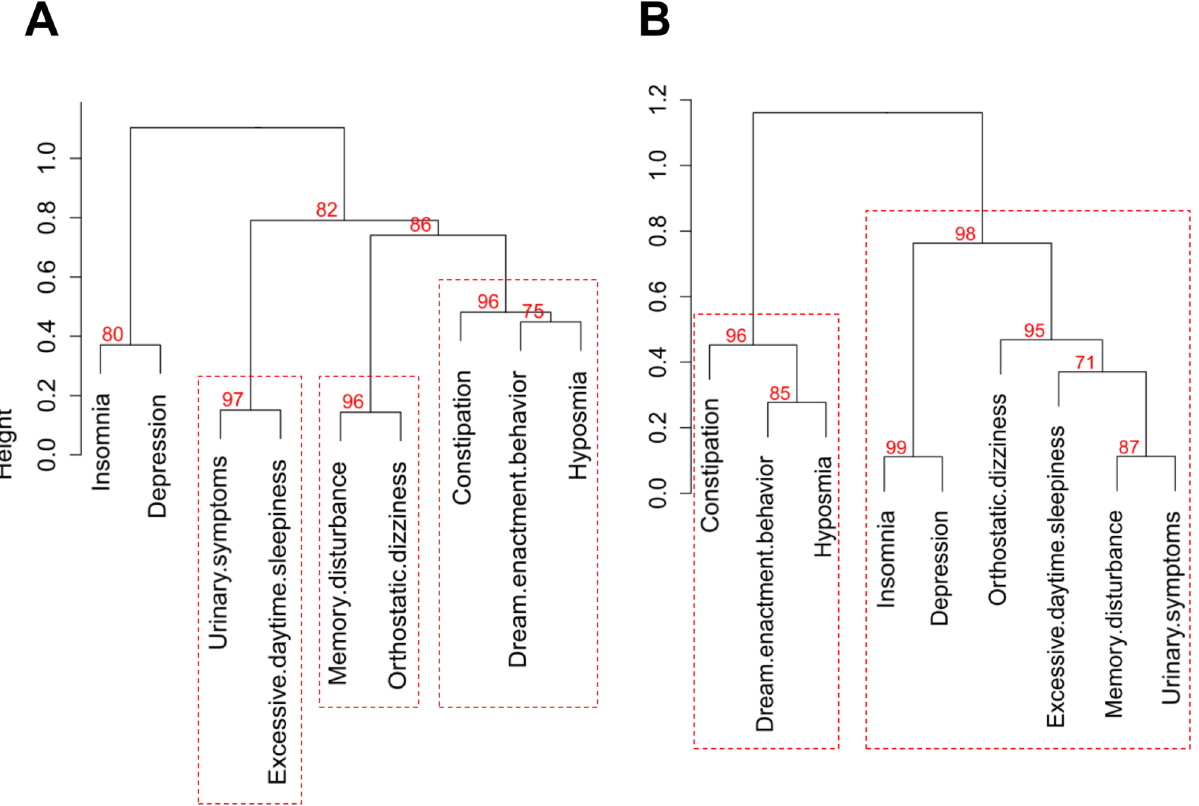
Figure 1. Dendrogram of the hierarchical cluster analysis and multiscale bootstrap resampling results of nonmotor features of Parkinson’s disease (PD). The clusters with an approximately unbiased (AU, red) P -value . 95% are highlighted by the red dashed rectangles. ( A ) all PD patients. ( B ) de novo PD patients. doi:10.1371/journal.pone.0091906.g001 PLOS ONE |